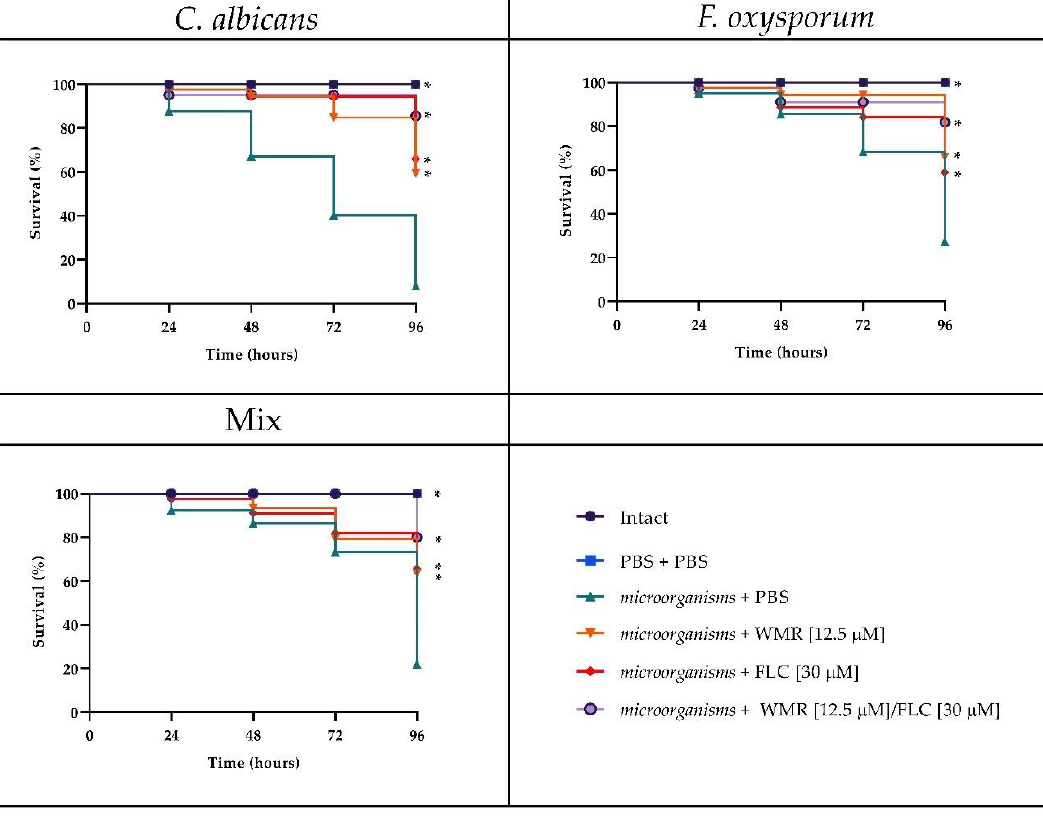
Figure 9. G. mellonella histopathology stained with hematoxylin and eosin. ( A , B ): C. albicans cells (arrow) and fungal hyphae (arrowhead) in infected G. mellonella larvae. ( C ): G. mellonella larvae treated with WMR peptide in combination with FLC. 4. Discussion Human-infecting pathogenic fungi are evolving resistance to all licensed systemic antifungal drugs. This increased incidence of drug resistance due to the implementation of antifungal drugs is an emerging problem that could be solved by alternative synergistic